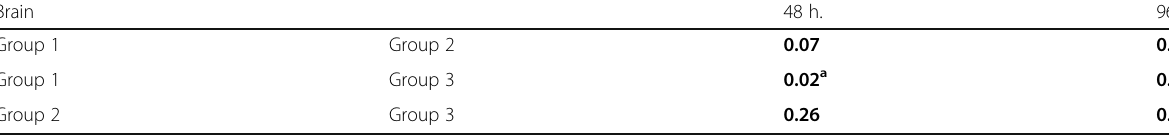
Table 4 A Pairwise Comparison between brain GAPDH of group1, 2, and 3 at 48 h and 96 h Brain